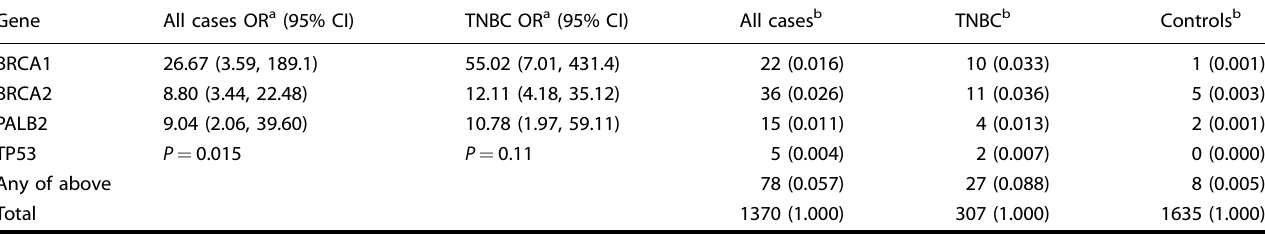
Table 2. Odds ratios for pathogenic variants in high-penetrance breast cancer genes for breast cancer of all subtypes and for TNBC compared to controls.